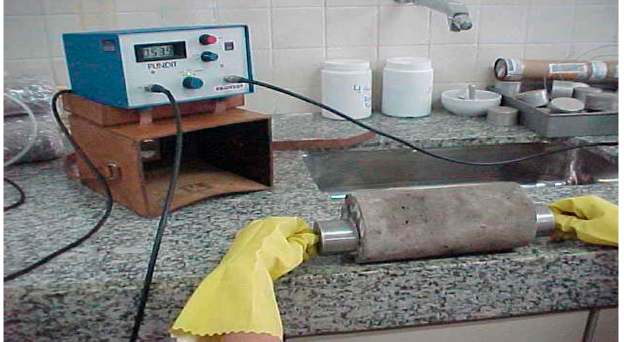
Figure 3. Ultrasonic Velocity Test.